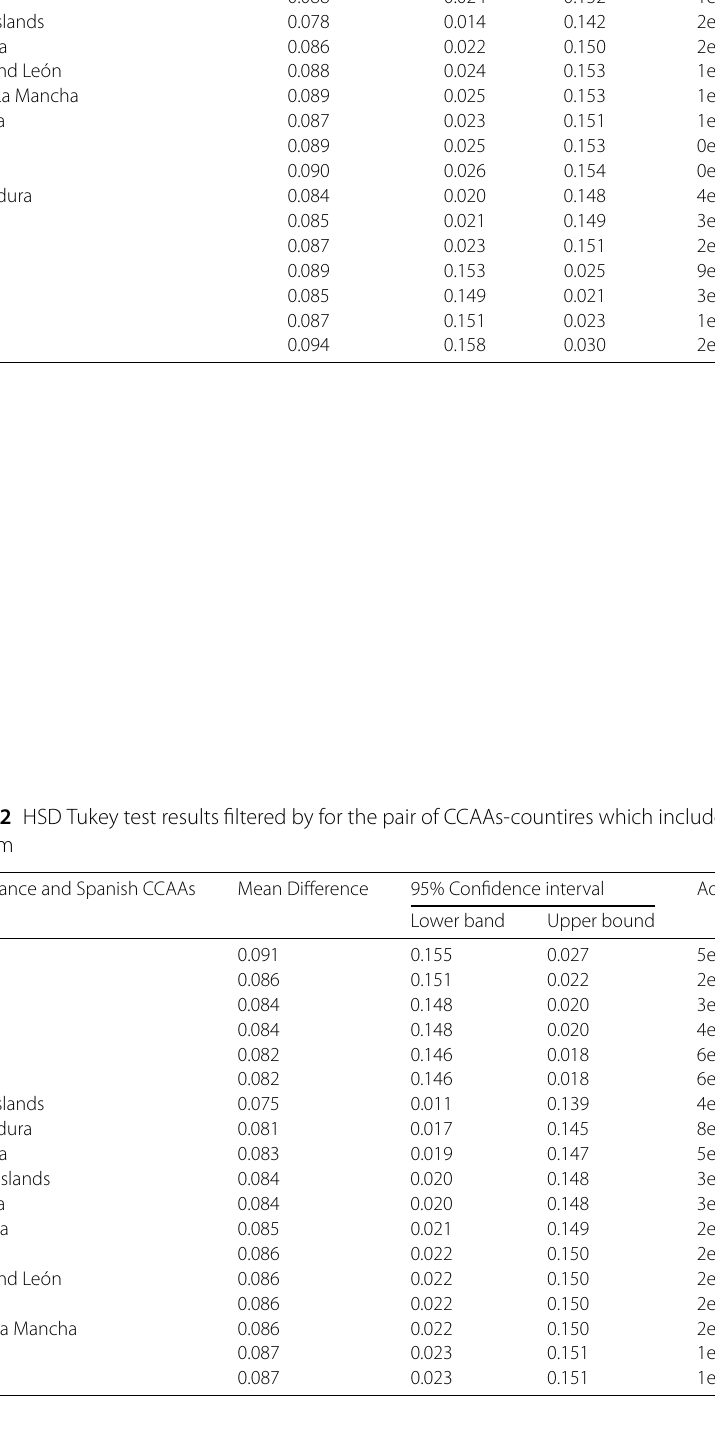
Table 11 HSD Tukey test results filtered by for the pair of CCAAs-countires which include Languedoc-Roussillon Pair of close French province (Languedoc- Roussillon) and Spanish CCAAs Andalusia